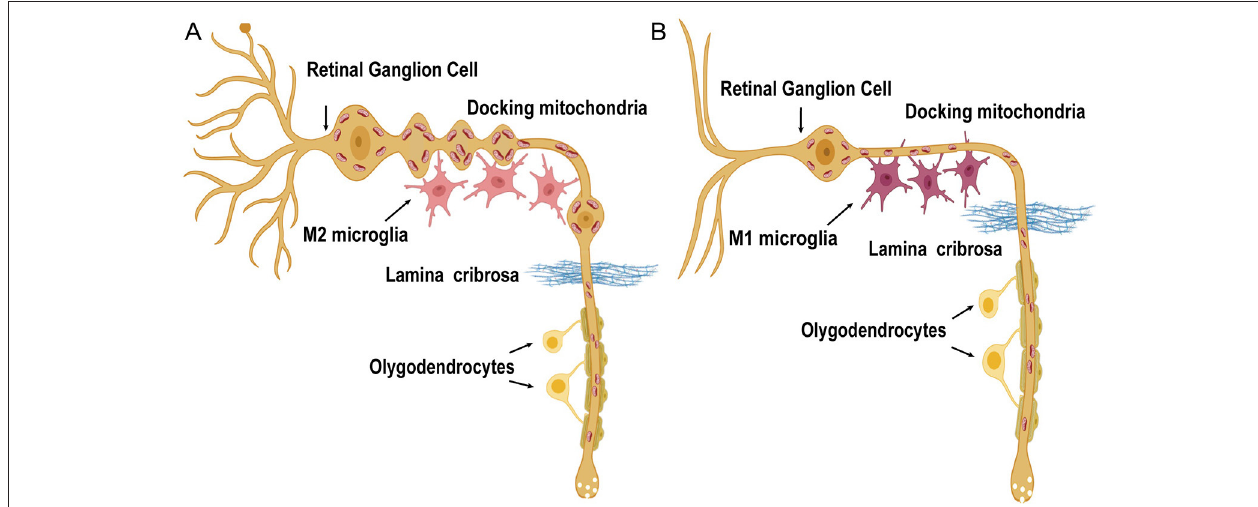
FIGURE 4 | Diagrammatic view of the pathogenic mechanisms in RNFL and GCIP degeneration in ALS patients. RGCs are characterized by unique long axonal segments running unmyelinated in the RNFL before these fibers cross the lamina cribrosa. Axonal mitochondria move bidirectionally along microtubule tracks and distribute asymmetrically in the RNFL. (A) In the early phase, preceding the loss of macular RGCs and RNFL axons, axonal swelling is observed. The M2 microglia predominate. (B) As the disease progresses, proinflammatory M1-type microglia are more common. Retinal nerve fibers degenerate together with the dendrites of RGCs [the schematic figure of the RGC is modified from Carelli et al.